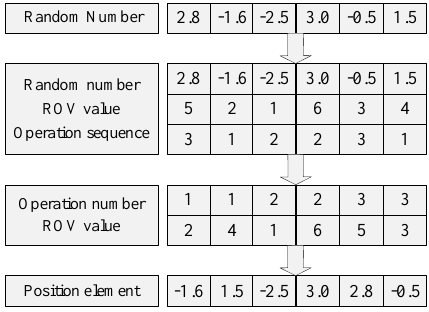
Figure 4. Transition from operation sequence to IPV.